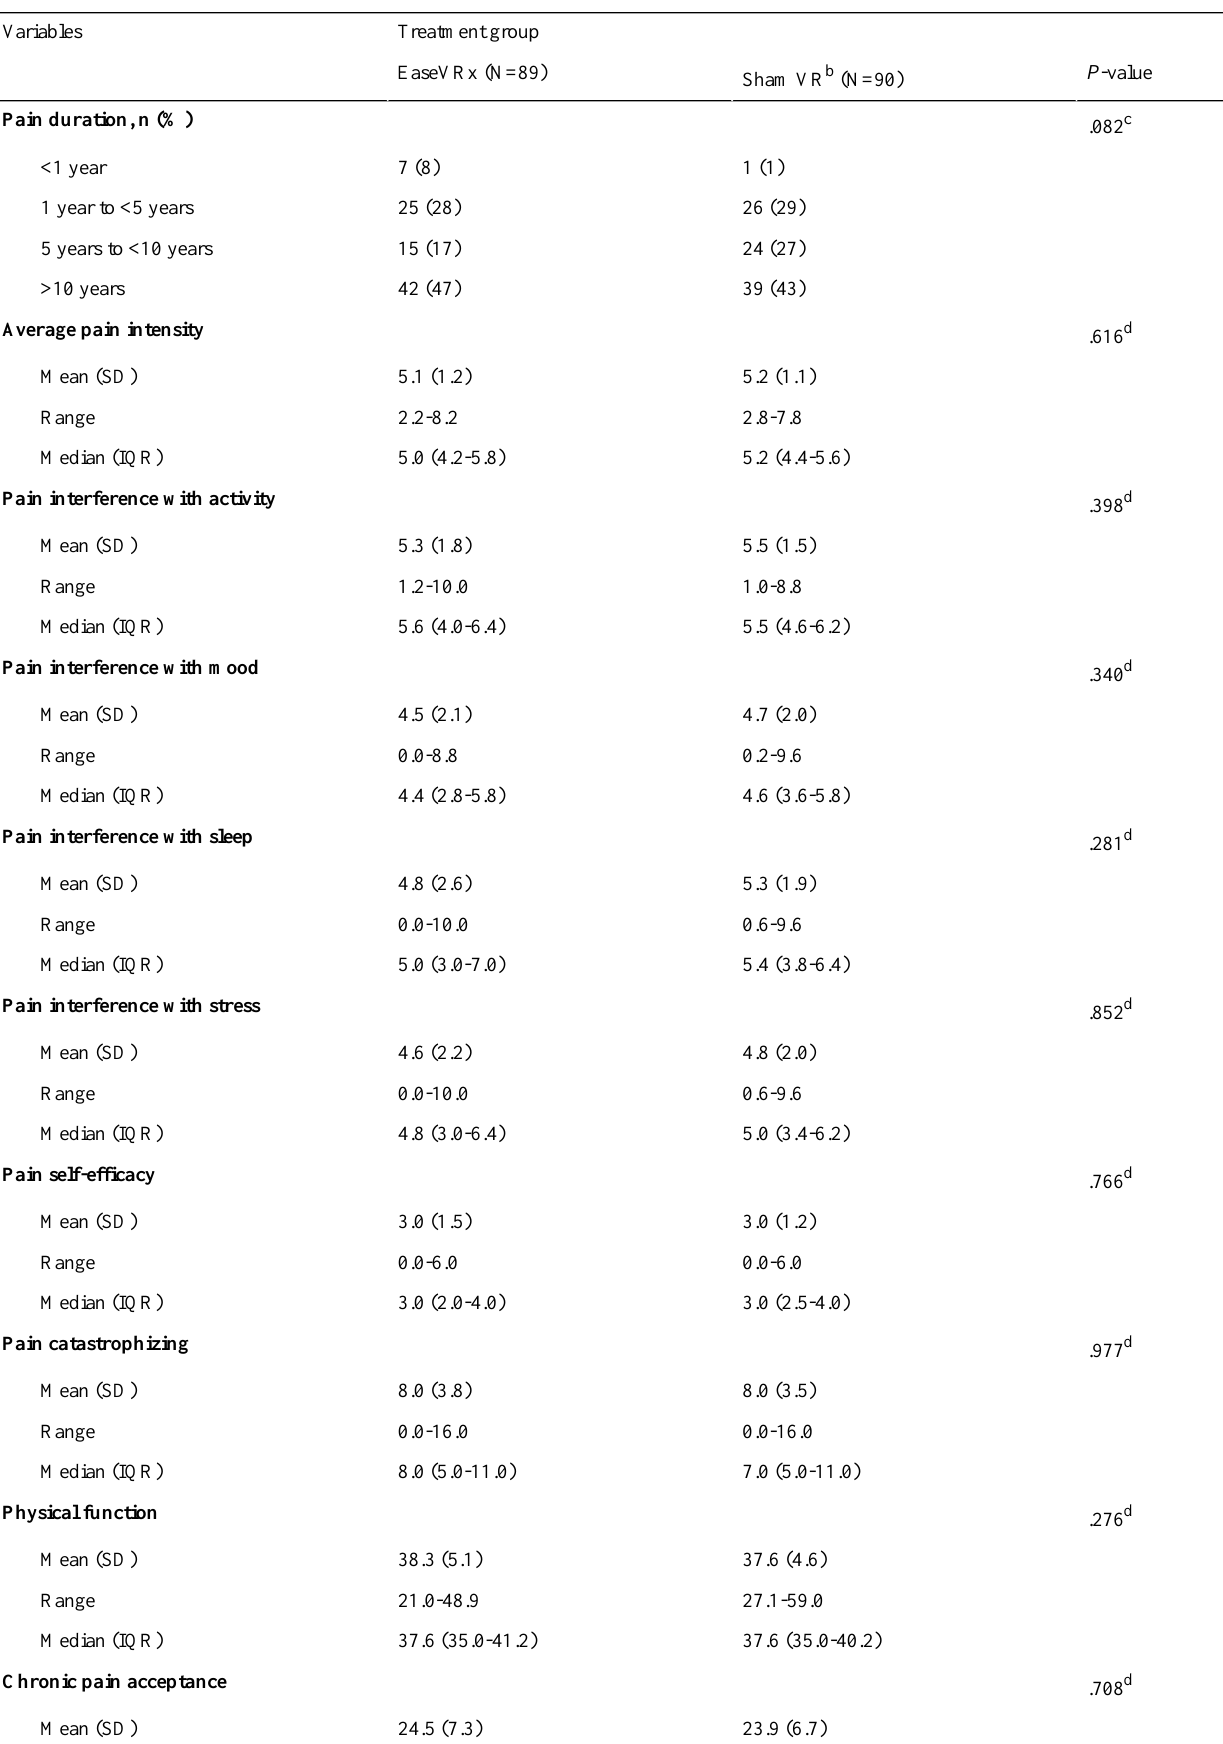
Table 3. Baseline clinical variables by treatment group.